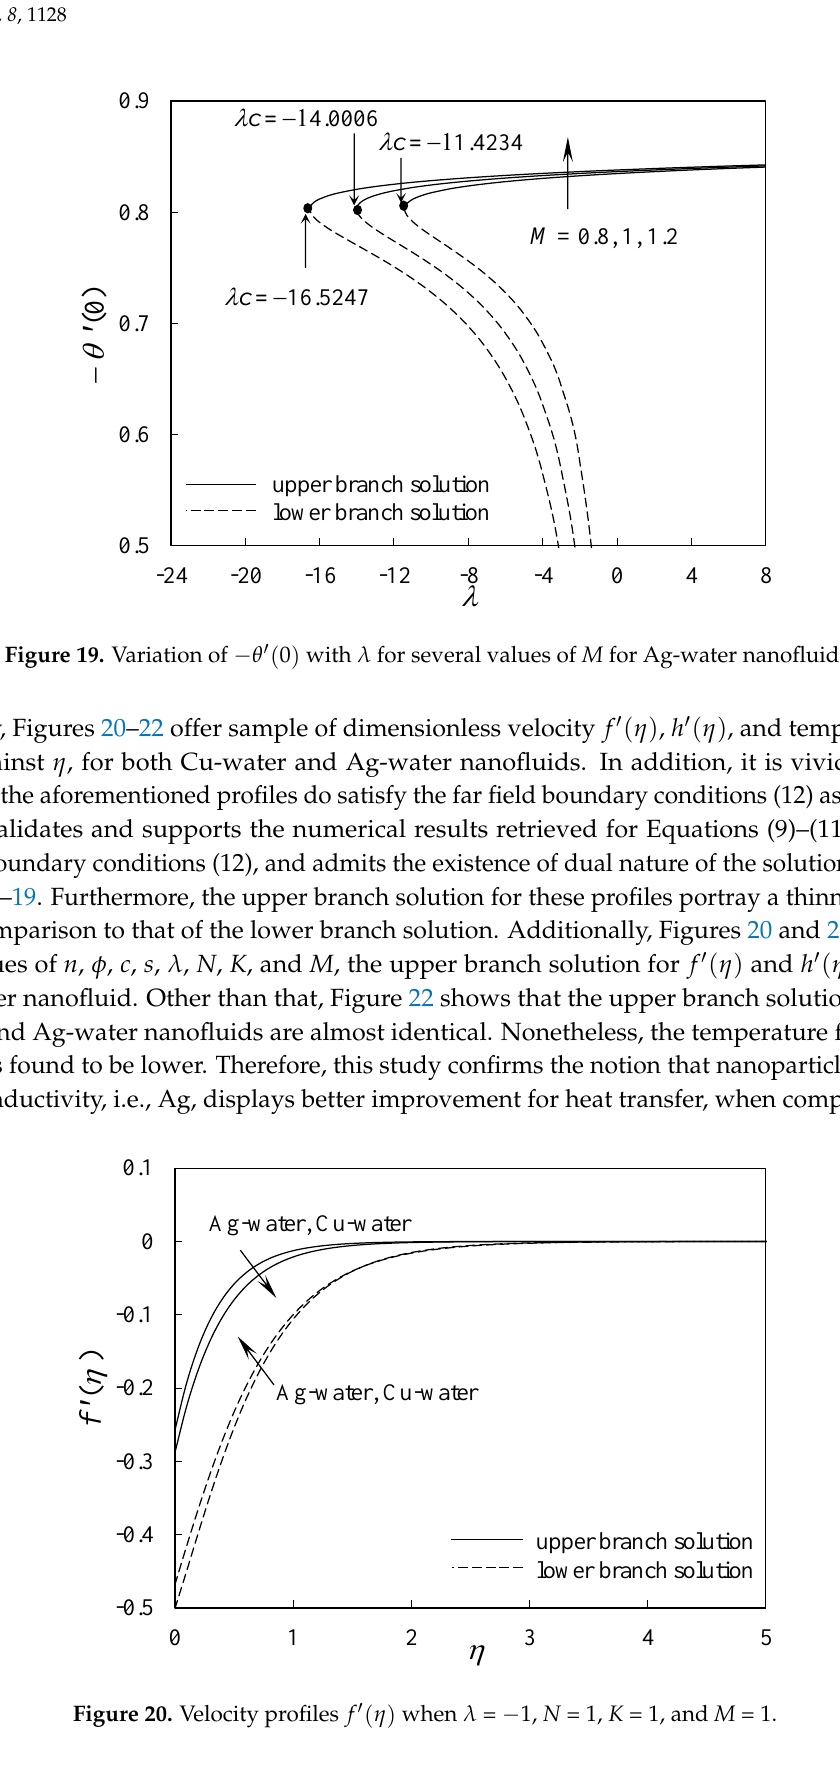
Figure 18. Variation of   0  with  for several values of M for Cu-water nanofluid.